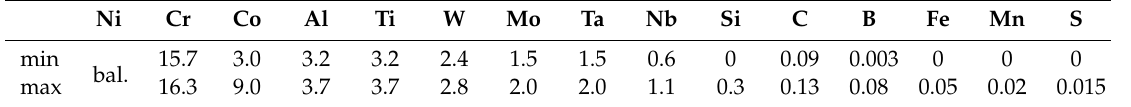
Table 1. Chemical composition of IN 738 LC in weight percent [13].